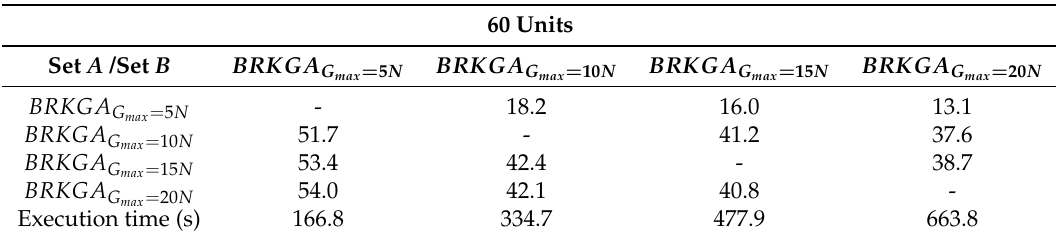
Table 5. Percentage of Non-dominated Solutions of set B covered by those in set A for case study 1 with pc = 0.7 and N p = 2 N